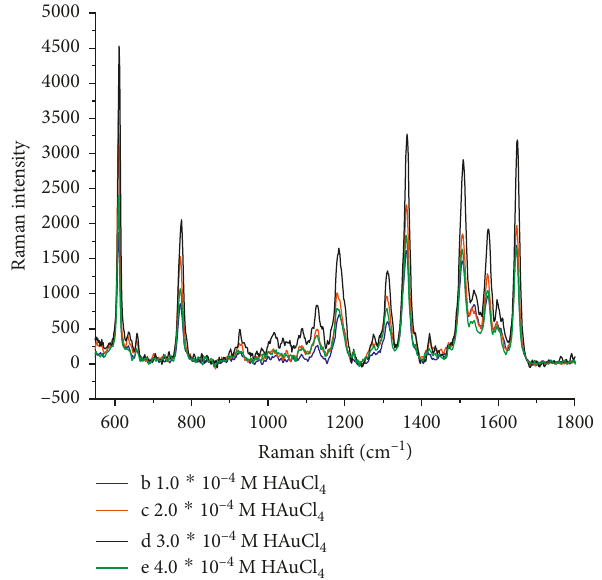
Figure 7: Raman spectra of the substrates reduced with different doses of HAuCl